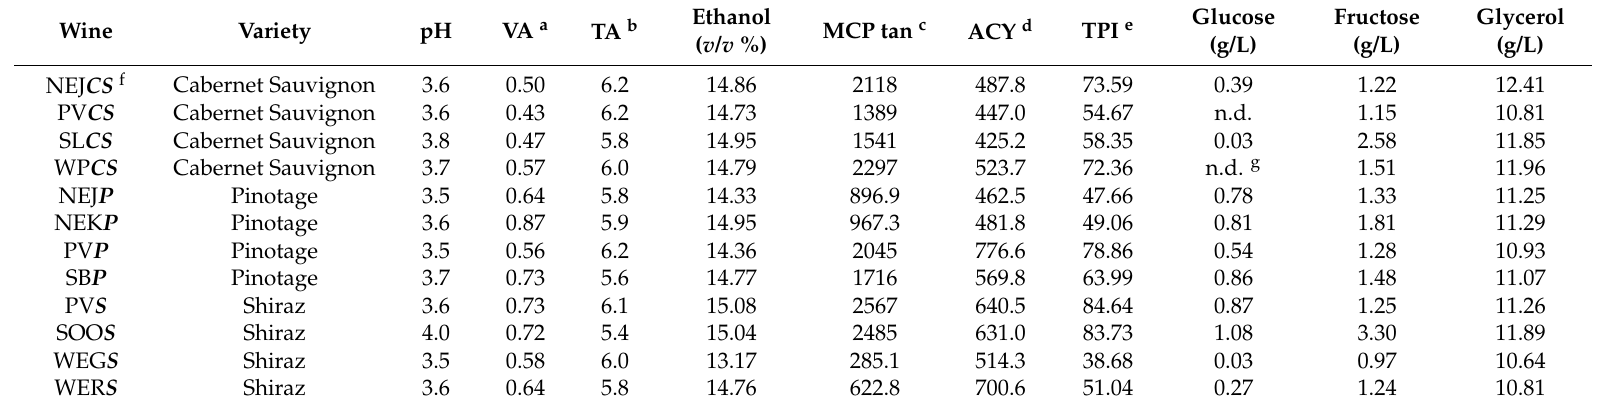
Table 1. Oenological parameters of the